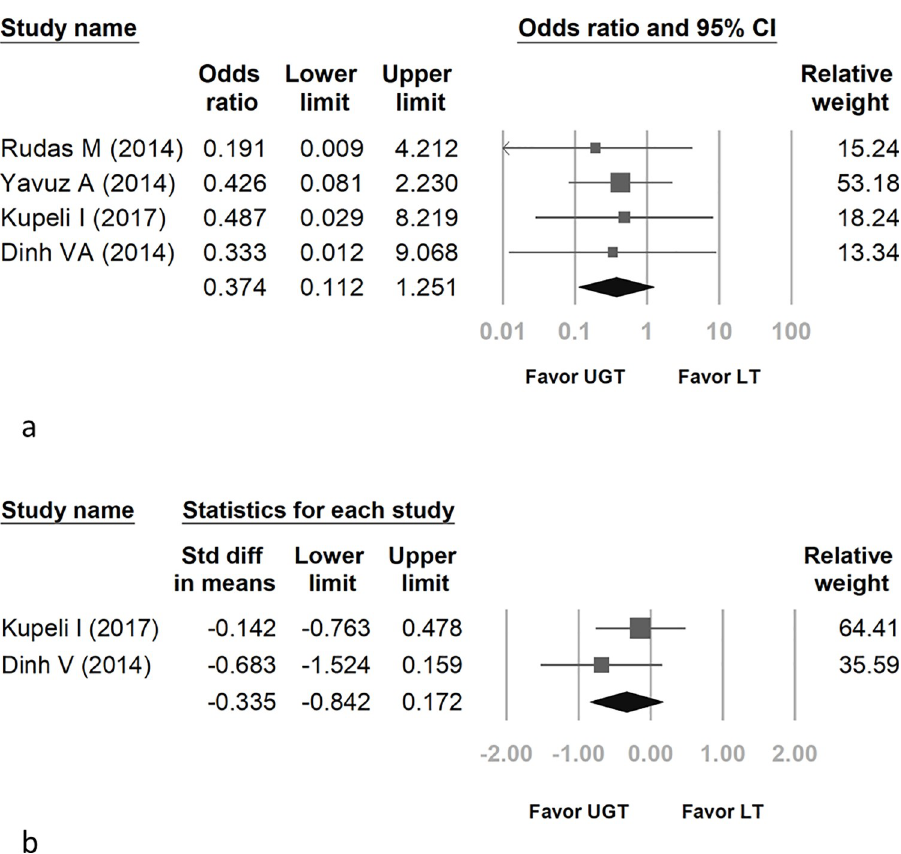
Fig 4. Forest plot comparing real-time UGT with LT for major bleeding (a) and total tracheostomy procedure time